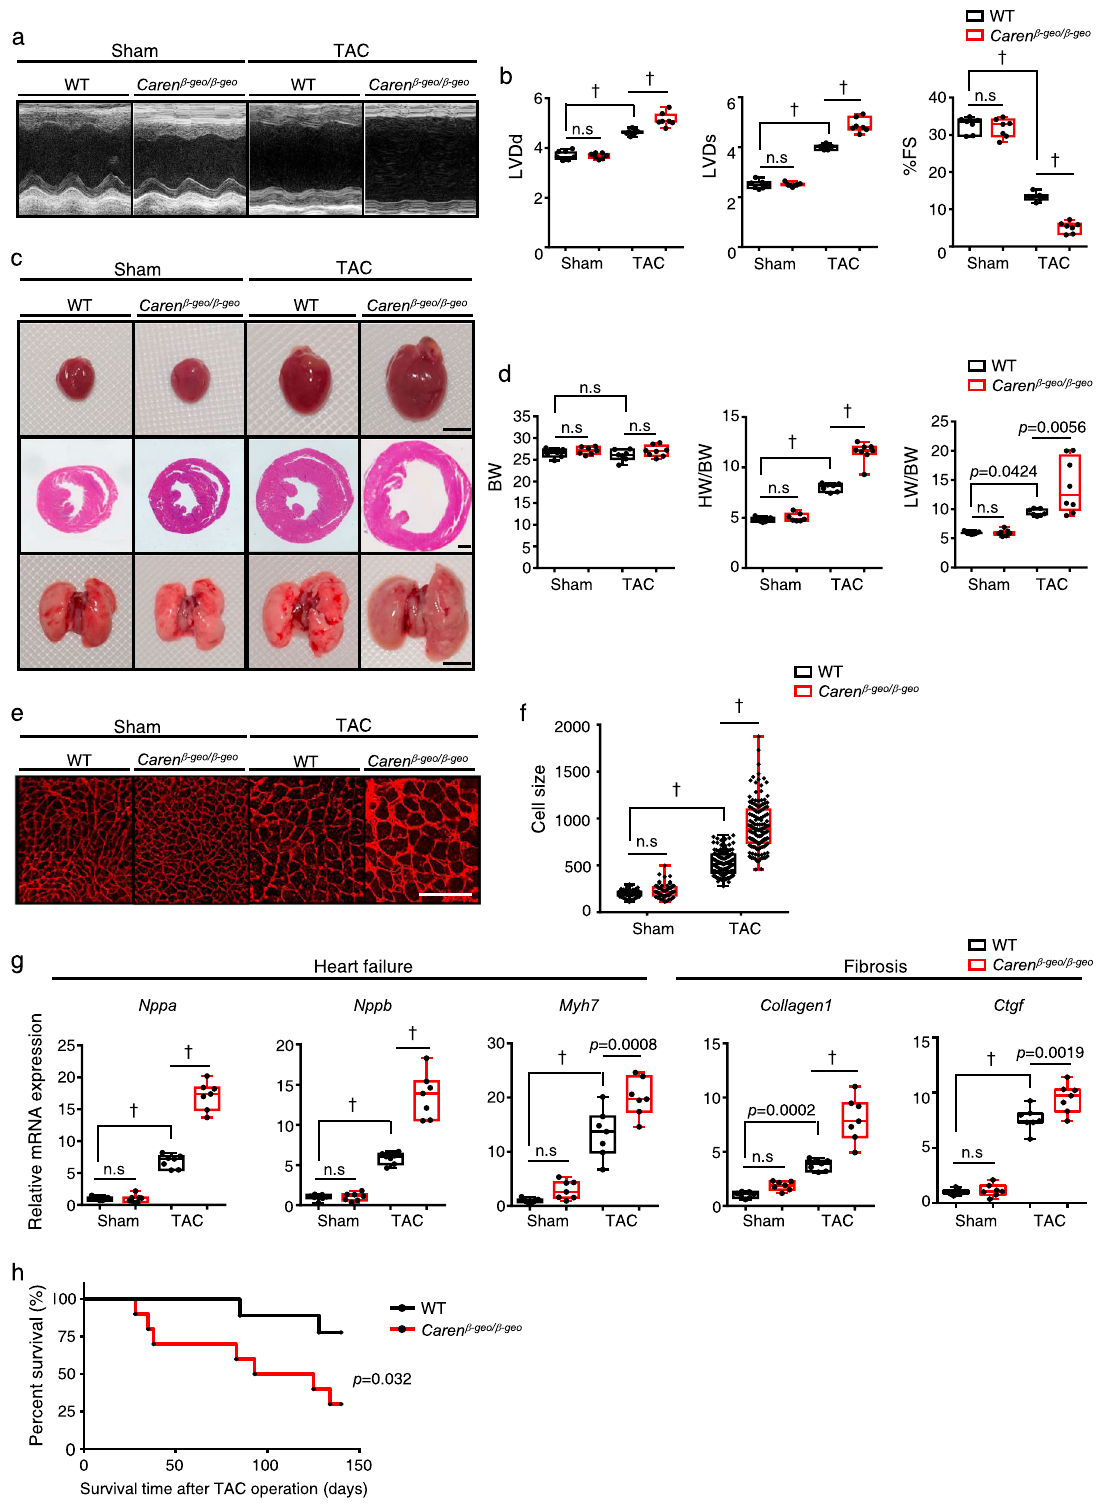
mice (Supplementary Fig. 6a, b). There was also no difference in the respiratory control ratio (RCR, state 3/state 4o) between CAG -Caren Tg and WT littermate mice (Supplementary Fig. 6c). BN-PAGE followed by immunoblotting analysis revealed com- parable levels of mitochondrial respiratory chain complexes in the heart between genotypes (Supplementary Fig. 6d), and there was no difference in activities of those complexes